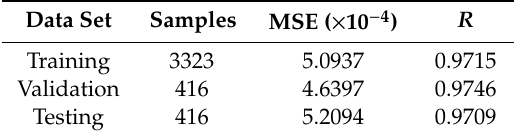
Table 3. Training performance of artificial neural network (ANN). MSE—mean squared error.